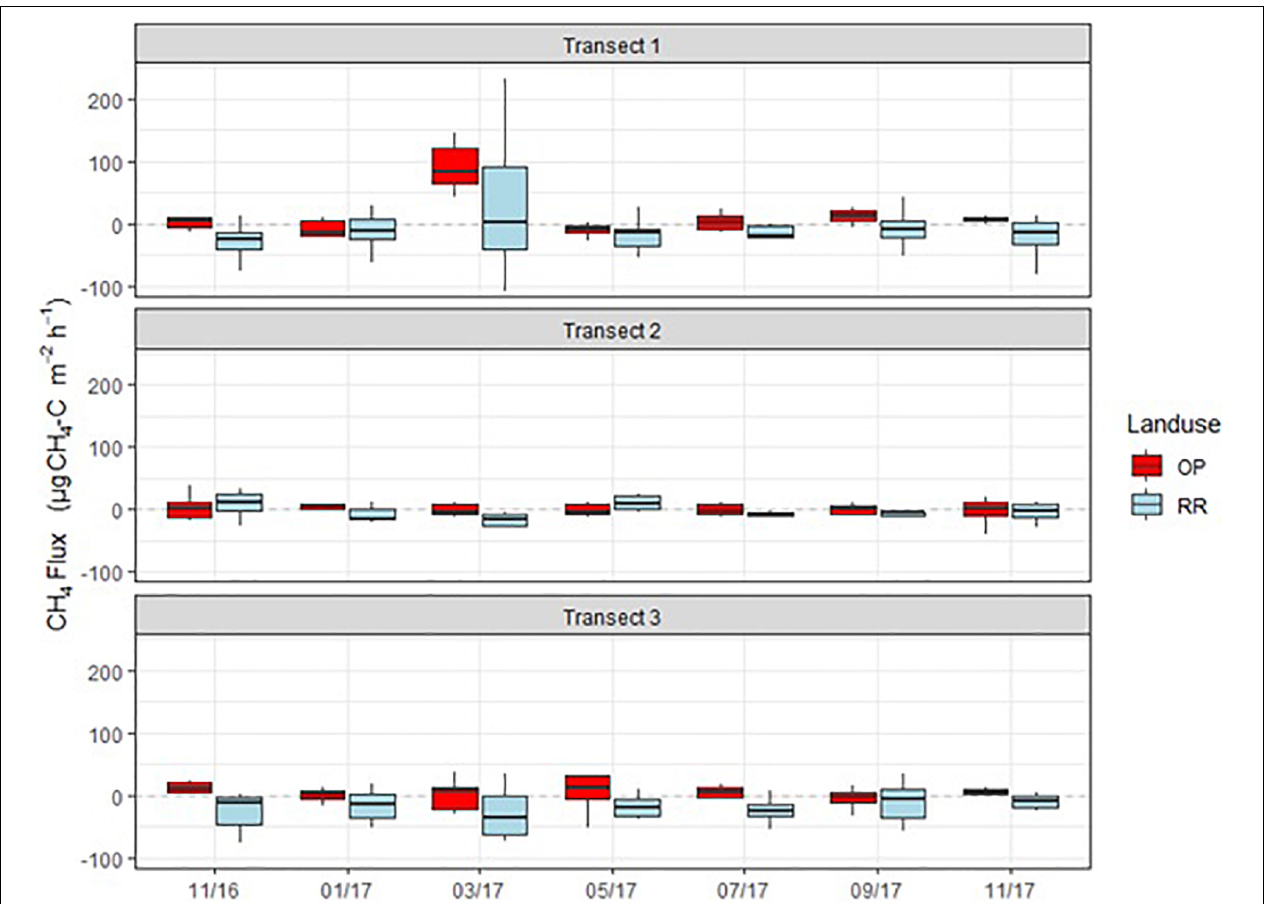
FIGURE 6 | Monthly CH 4 -C fluxes ( µ g m − 2 h − 1 ) from the three transects (1–3), OP, oil palm (red); RR, riparian forest (blue). The lower and upper hinges correspond to the first and third quartiles (the 25th and 75th percentiles), lower whisker = smallest observation greater than or equal to lower hinge –1.5 × IQR (inter quartile range), upper whisker = largest observation less than or equal to upper hinge +1.5 × IQR. The median is marked by a horizontal line inside the